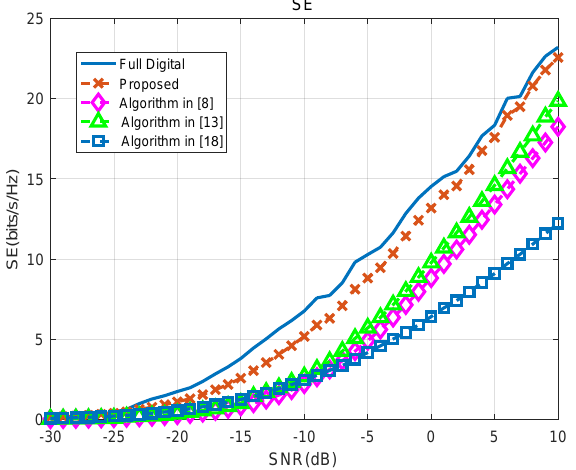
Figure 5. SEs of different algorithms, and M t = 8, M r = 4, K =